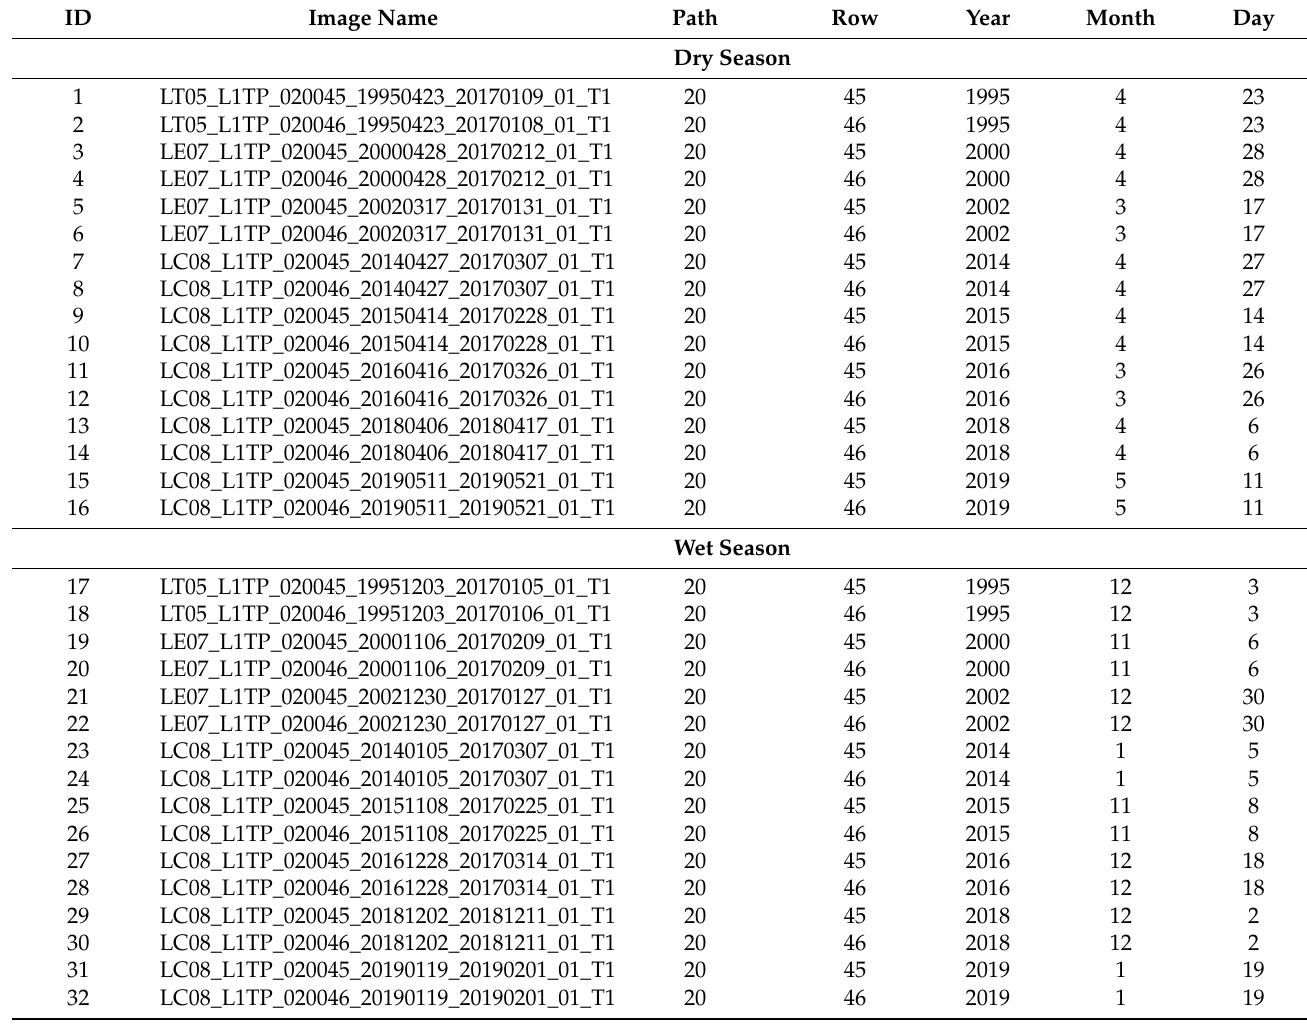
Table 1. List of Landsat images used to carry out the analysis.